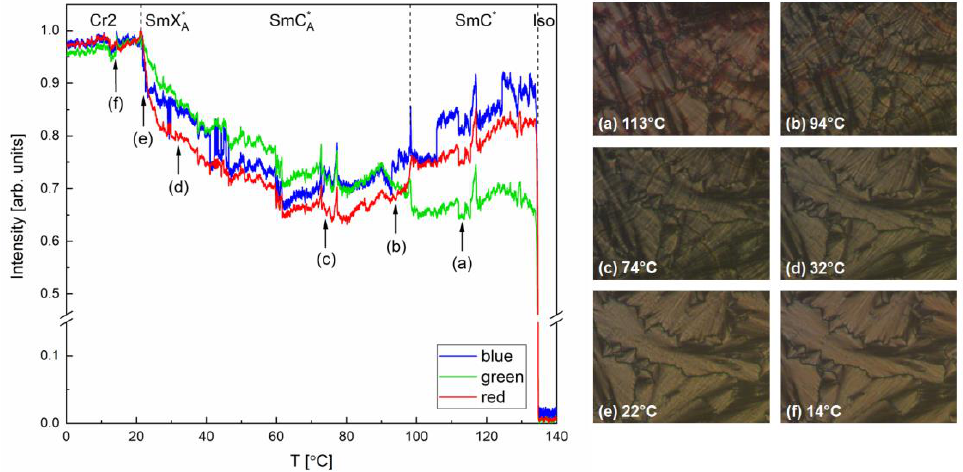
Figure 5. Analysis in TOApy [21] using ‘rgb’ algorithm of POM results for 4HH (cooling, 6 °C/min). Representative textures are shown as well.